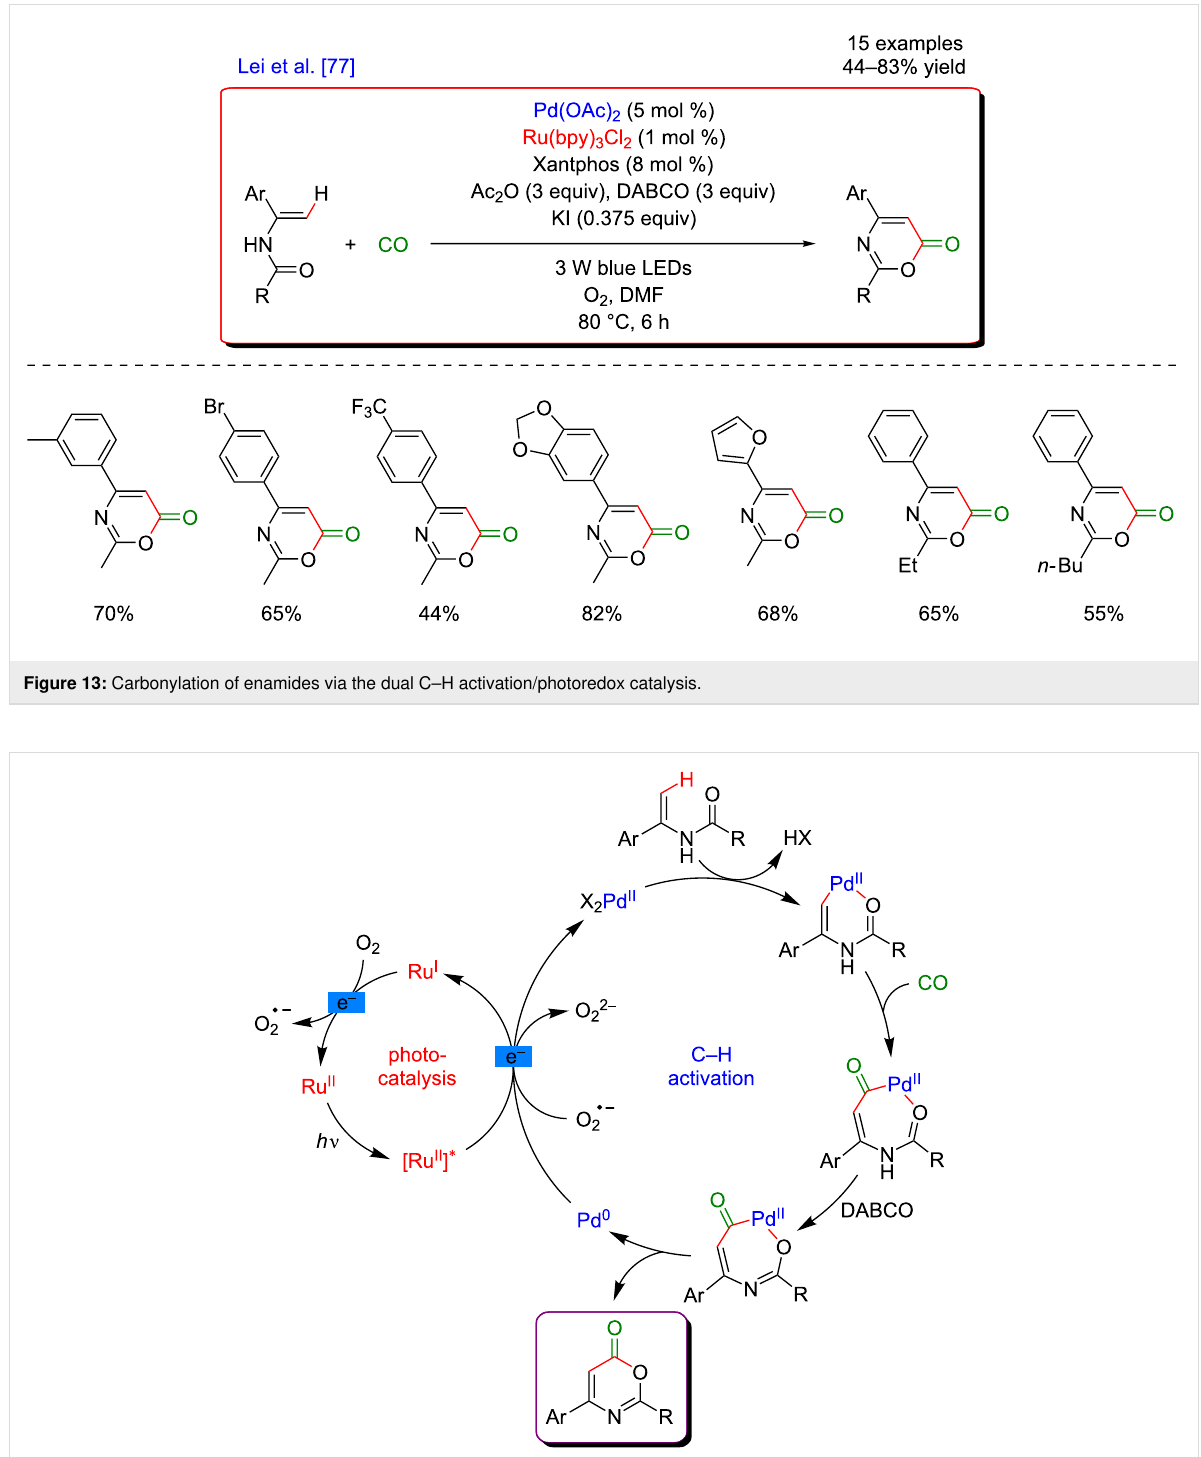
goes a single-electron transfer (SET) oxidation to Co(III) with a concomitant formation of the reduced organic